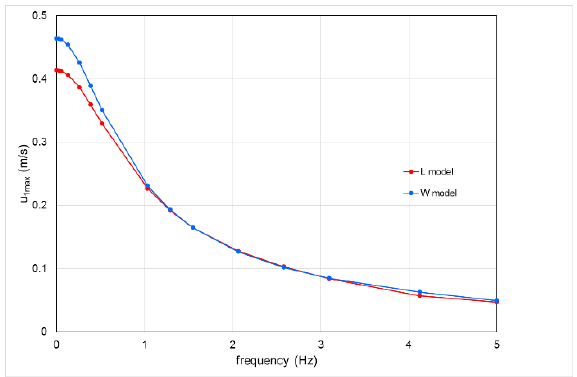
Figure 3. Steady component of velocity for W and L models.